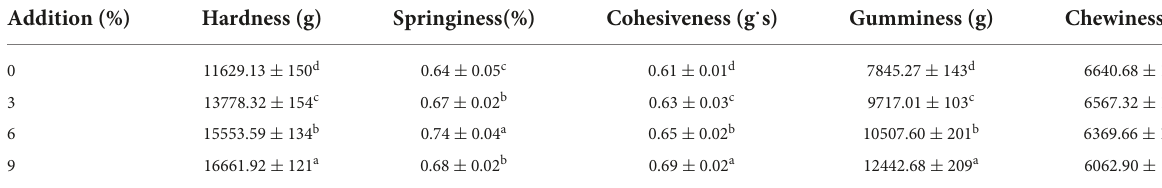
TABLE 1 Texture properties of the noodles treated with different MMBP amounts.